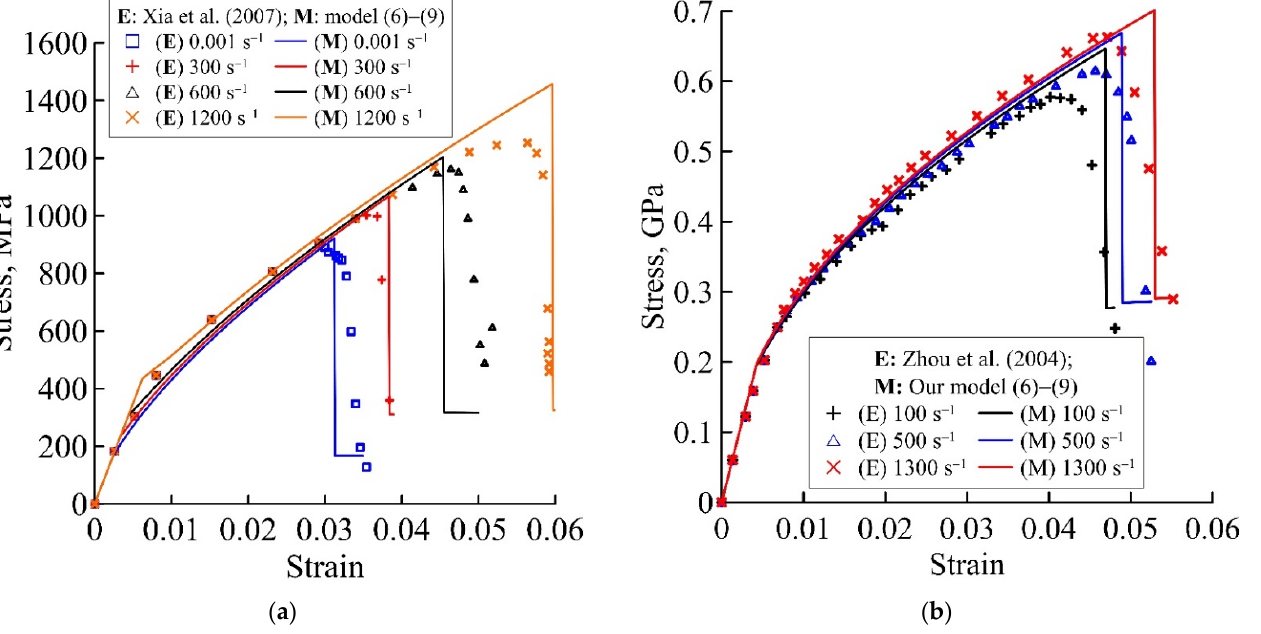
Figure 4. Predicted static and dynamic deformation curves of Al/CFRP/Al/CFRP/Al and Al/KFRP/Al/KFRP/Al laminates using the proposed model (6)–(9), marked by solid lines, with close values for the total thickness ratios for the metal and polymer layers: ( a ) 1.23 and ( b ) 1.16. Experimental static and dynamic deformation curves for ( a ) Al/CFRP/Al/CFRP/Al [45] and ( b ) Al/KFRP/Al/KFRP/Al [46] are marked by points.